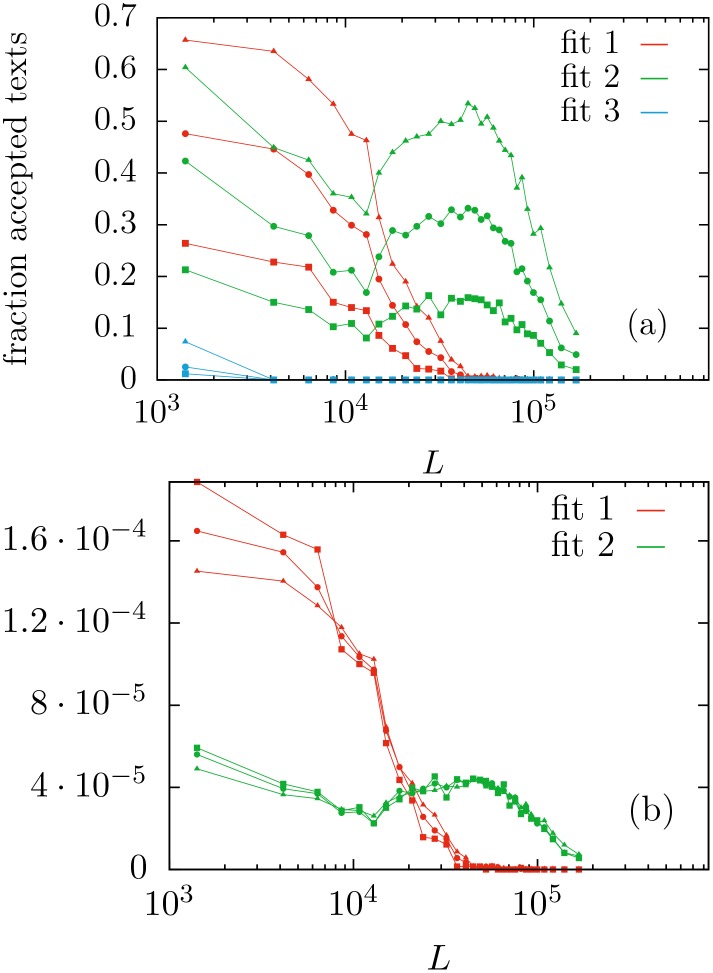
(a) Histograms showing the fraction of accepted texts by the three distributions as a function of their text length, for three different significance levels p0: 0.05 (upper curves), 0.20 (middle), 0.50 (lower). To be concrete, for each range of L, the ratio between the number of texts with p ≥ p0 and the number of texts in that range is calculated. (b) Same curves (removing those for distribution 3) under rescaling. We rescale the y—axis by the number of p ≥ p0, in each case, showing that the relative performance of each fit with regard L is independent on the significance level. Bins are selected to contain 1000 texts each.